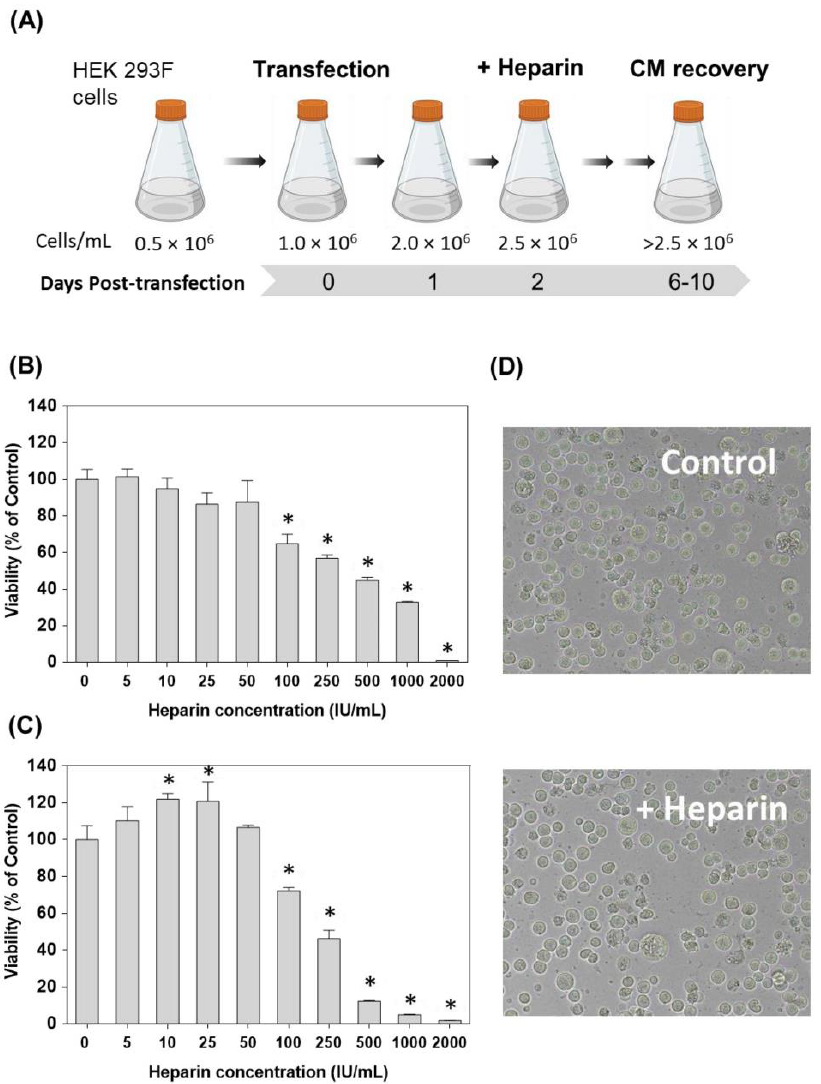
Figure 1. Schematic representation of the optimized pipeline for the production of ECM proteins with affinity by heparin. ( A ) HEK 293F cells were seeded at a cell density of 0.5 × 10 6 cells/mL. After 24 h, cells were transfected with the DNA/PEI mix, and after 48 h, the cell culture was supplemented with 50 IU/mL of sodium heparin to enhance protein production. After the appropriate incubation time (typically between 7 and 10 days), the cell culture can be recovered, centrifuged and the conditioned medium (CM) used for protein purification. ( B , C ) The cytotoxicity of sodium heparin against HEK 293F cells was evaluated after ( B ) 24 and ( C ) 72 h of treatment with heparin at a concentration up to 2000 IU/mL. Fifty IU/mL was the highest concentration of sodium heparin that did not cause notable cytotoxicity against HEK 293F cells. ( D ) Representative images of HEK 293F cells after 72 h incubation, with or without 50 IU/mL of sodium heparin. In ( B ) and ( C ), data are shown as mean ± SD of three independent experiments. One-way ANOVA followed by Sidak’s multiple comparisons test to evaluate the effect of heparin on cell viability. The asterisk represents a significant difference in means between heparin treatment and control cells when an α of 0.05 is consid- ered.